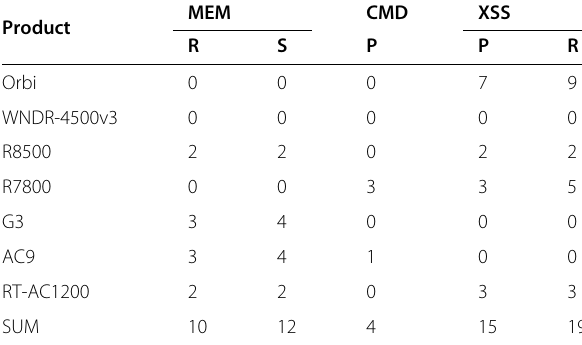
D-CONF Mode Fuzzing